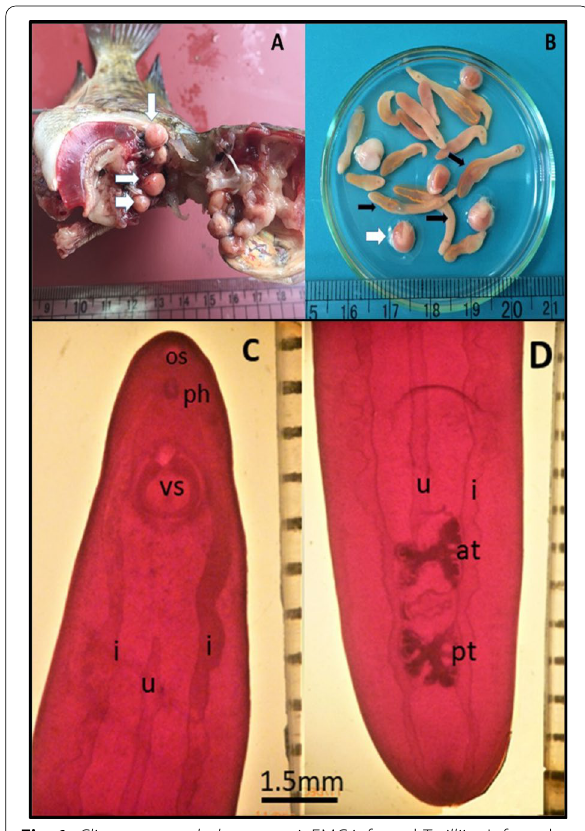
Fig. 1 Clinostomum phalacrocoracis EMC infected T. zillii . a Infected buccal cavity with EMC (white arrows) and ExMC (black arrow). b Fresh specimens of encysted MC (white arrows), ExMC (black arrow). c, d Stained specimens of C. phalacrocoracis ; oral sucker (os), Pharynx (ph), ventral sucker (vs), intestinal ceca (i), uterine tube (u), anterior testis (at), posterior testis (pt), intestinal ceca (i)) scale bar 2